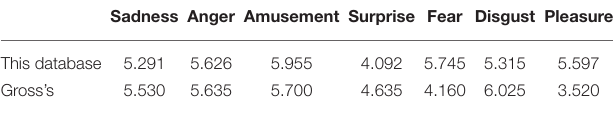
TABLE 4 | Ratings of target emotion compared this database with Gross and Levenson